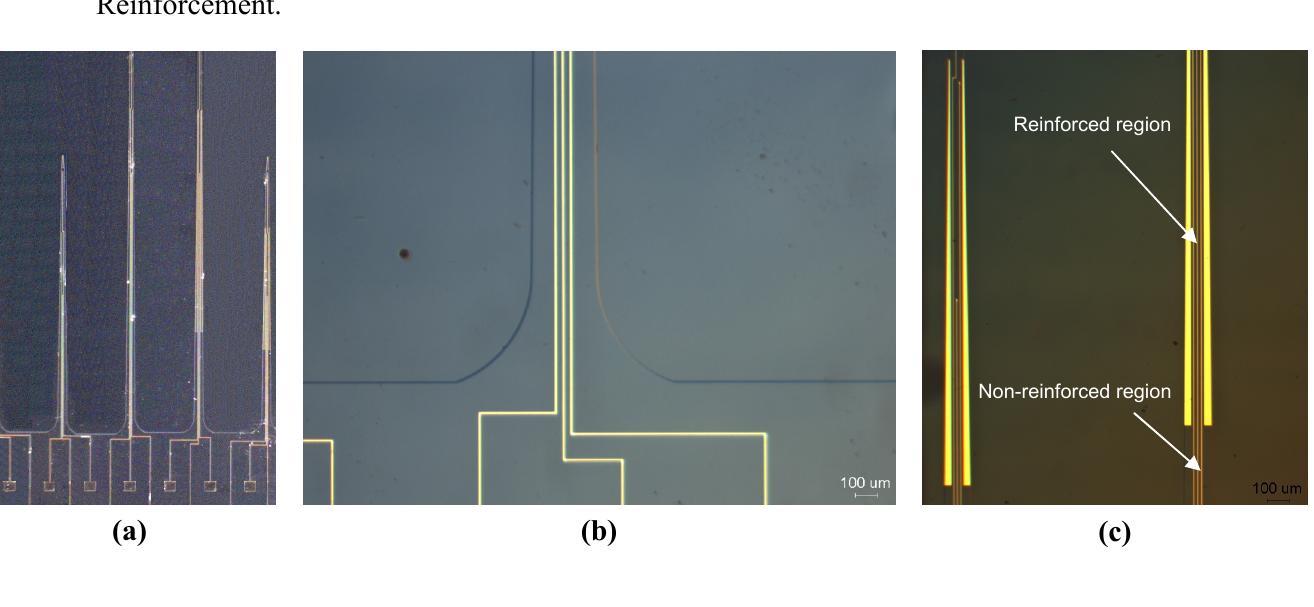
Figure 12. Multi-electrode probe array fabricated by using the MicraGEM process from Micralyne. (a) The multi-length array. (b) Tapered base of the probe. (c) Probe